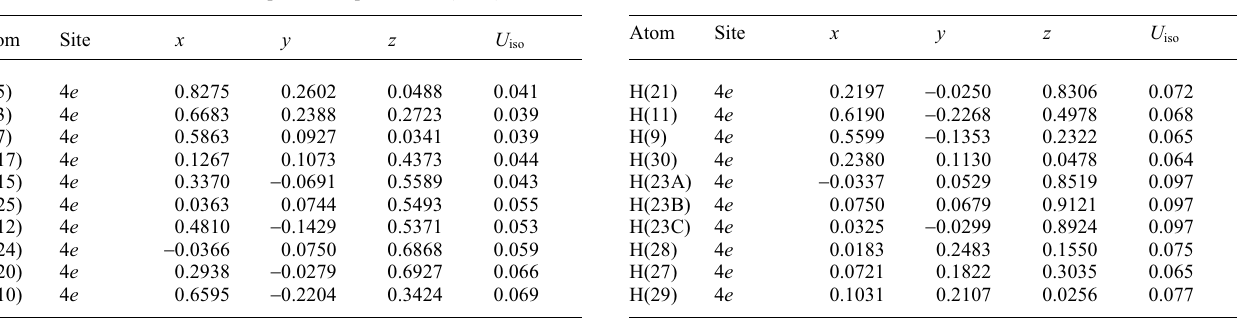
Table 2. Atomic coordinates and displacement parameters (in Å 2 )